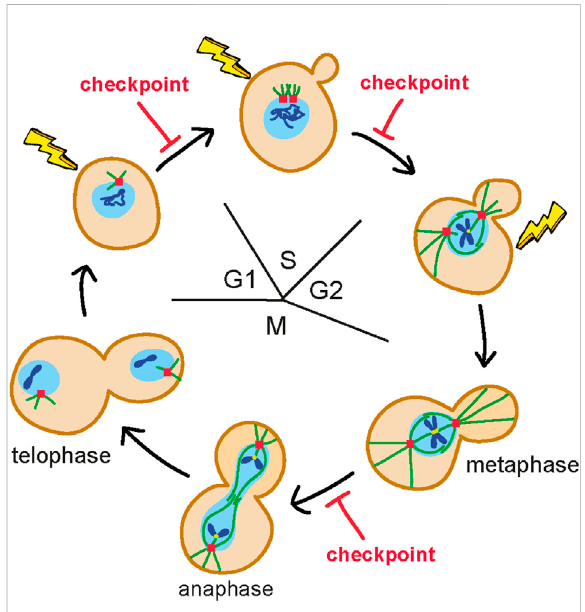
FIGURE 1 Budding yeast mitotic cell cycle. During the G1 phase, cells are unbudded and contain a single spindle pole body (SPB) (red square).OncecellsbecomecommittedtoenterSphase,theystart budding, duplicate the SPB and replicate DNA (blue lines). In G2, the mitotic spindle (green lines) is assembled along the mother-daughter axis and the nucleus (light blue circle) moves to the bud neck. In M phase, duplicated chromosomes get attached (yellowdots)tothemicrotubulesinabipolarmannerinmetaphase and are pulled apart during anaphase. Once chromosome segregation is completed (telophase), the spindle disassembles and the 2 cells get physically separated. The nuclear envelope does not breakdown. Only one chromosome is shown. DNA damage in G1 activates a checkpoint that arrests the G1/S transition, whereas DNA damage in G2 after completion of DNA replication activates a checkpoint that arrests the metaphase to anaphase transition. Detection of DNA lesions during S phase elicits a checkpoint response that controls completion of DNA replication before cells enter M